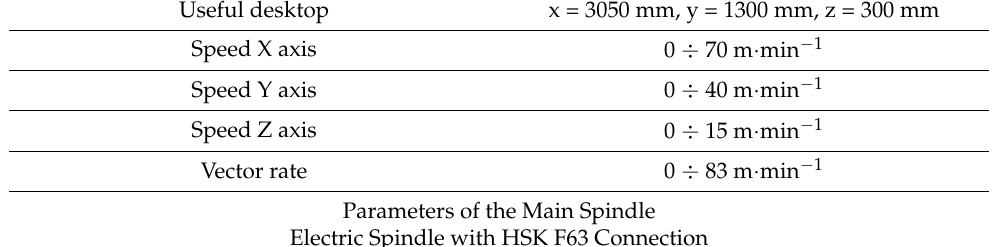
Table 1. Technical and technological parameters of CNC Machining Centre SCM Tech Z5 used in this work. Useful desktop